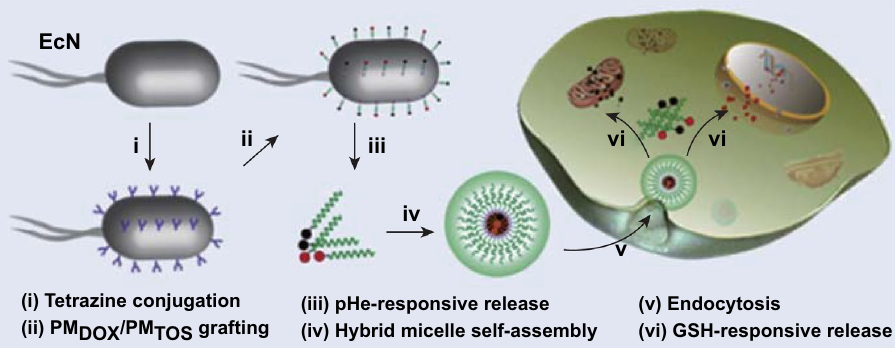
Fig. 2 Schematic of bacterial microrobot delivery and release of active drugs for cancer treatment. (1) tetrazine derivatives are conjugated on the surface of EcN; (2) grafting of micellar polymer containing DOX and α-tocopheryl succinate (PM DOX /PM TOS ) by bioorthogonal reactions; (3) the PM DOX /PM TOS copolymers are released from the bacterial microbots in response to tumor pHe; (4) PM DOX and PM TOS self-assemble to form hybrid micelles; (5) hybrid micelles are endocytosed into tumor cells; (6) micelles release DOX and α-tocopheryl succinate in response to cytosolic GSH. Reprinted with permission from Ref.